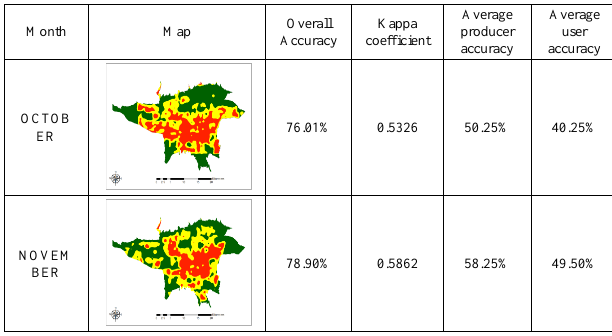
Table 5. Maps and the results of the last two months of 2014 (green: Clear, Yellow: low density, red: high density)